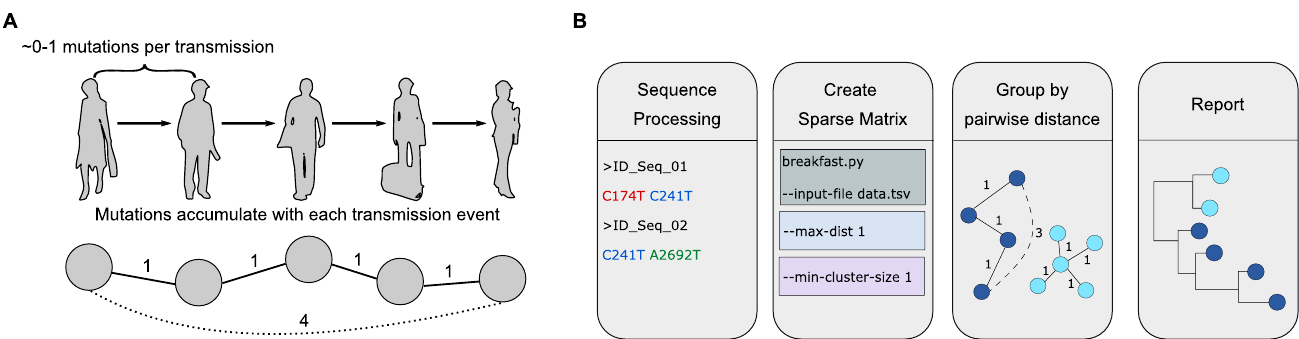
Figure 2. The power of SARS-CoV-2 genotyping and SNP-based clustering for contextual outbreak assessment. ( A ) We expect the viral genomes to accumulate mutations, as they are transmitted from one individual to the next. An efficient method to identify chains of genetically similar sequences would therefore be useful to identify putative outbreaks. ( B ) Diagram illustrating the steps of the clustering algorithm using a maximum SNP distance of 1. The mutation profiles are obtained by a reference-based alignment with Nextclade [17] or covSonar (https://github.com/rki-mf1/covsonar (accessed on 3 May 2022)). The pairwise distances between different sequences are derived from the constructed distance matrix of genomic profiles. Two sequences are part of the same transmission cluster if the pairwise distance between them is below the user-specified threshold, max-dist. The final transmission clusters can be further analyzed with phylogenetic